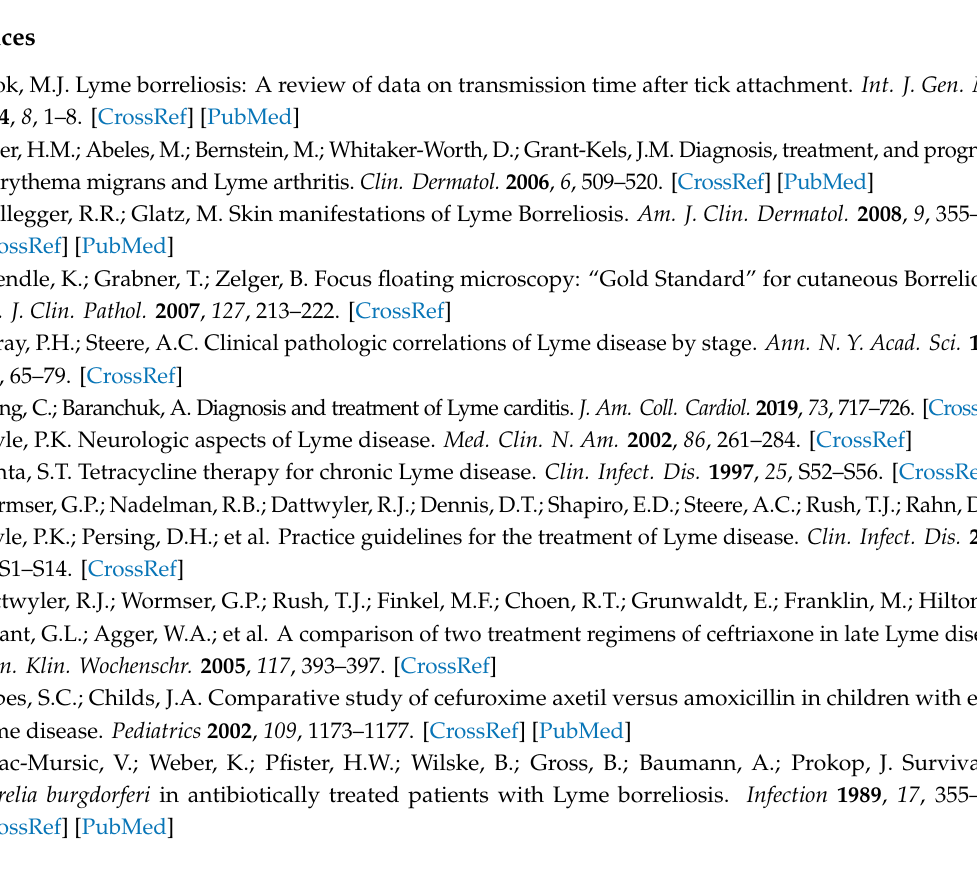
Figure S1: Three-dimensional analysis of biofilm form of B. burgdorferi via confocal microscopy in infected biopsies inoculated with 1 × 10 7 spirochetes and cultured in BSK-H 6% RS. Panel A shows biofilm marker alginate (red); panel B illustrates B. burgdorferi (green); panel C shows DIC microscopy images; and panel D represents DAPI (blue) staining. 630 × magnification. Scale bars show 10 µ